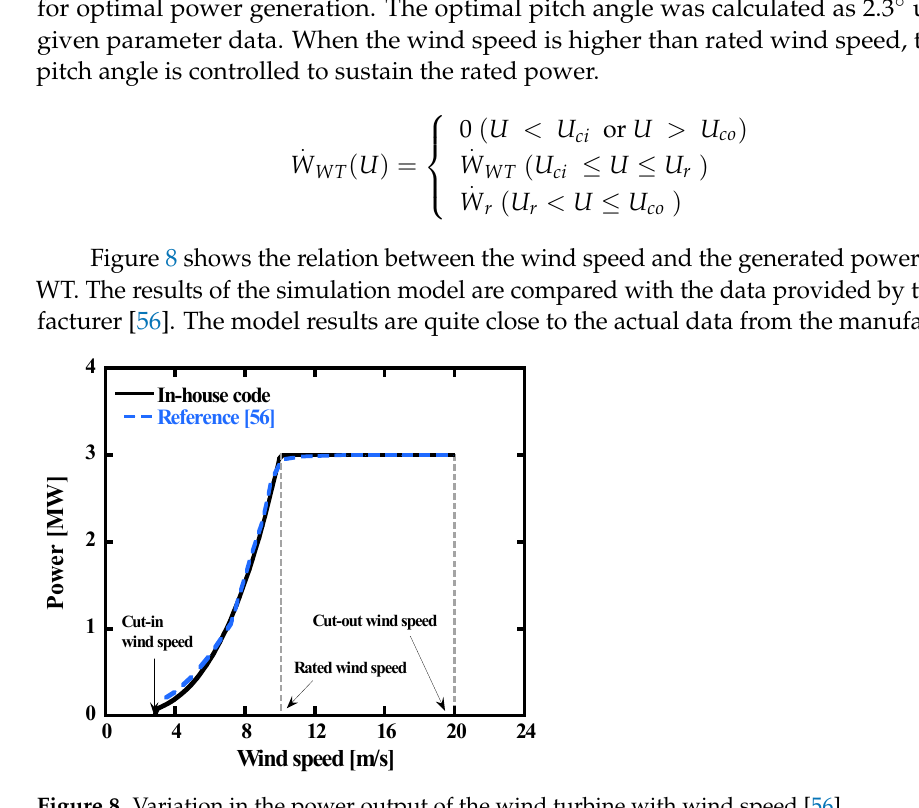
Figure 8. Variation in the power output of the wind turbine with wind speed